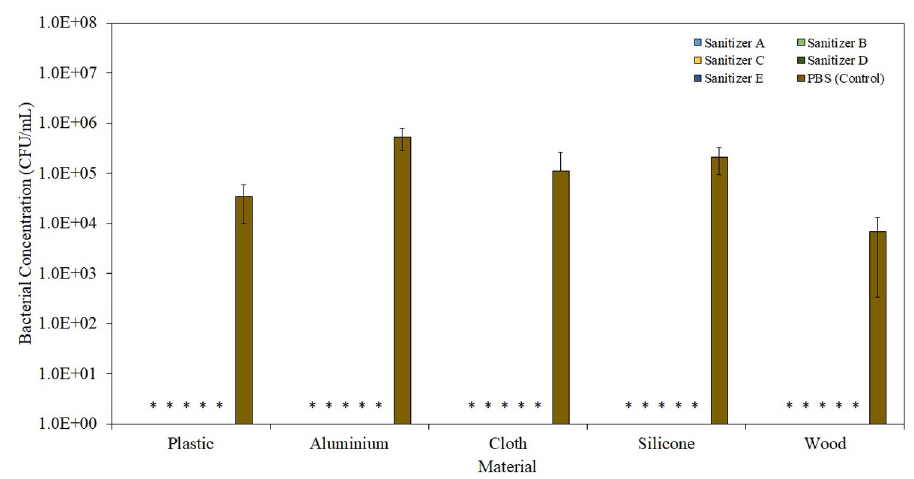
Fig 3. Instant sanitization functionality of respective alcohol-based sanitizers on different types of materials and surfaces. � indicates P < 0.05 as compared to the control (PBS).